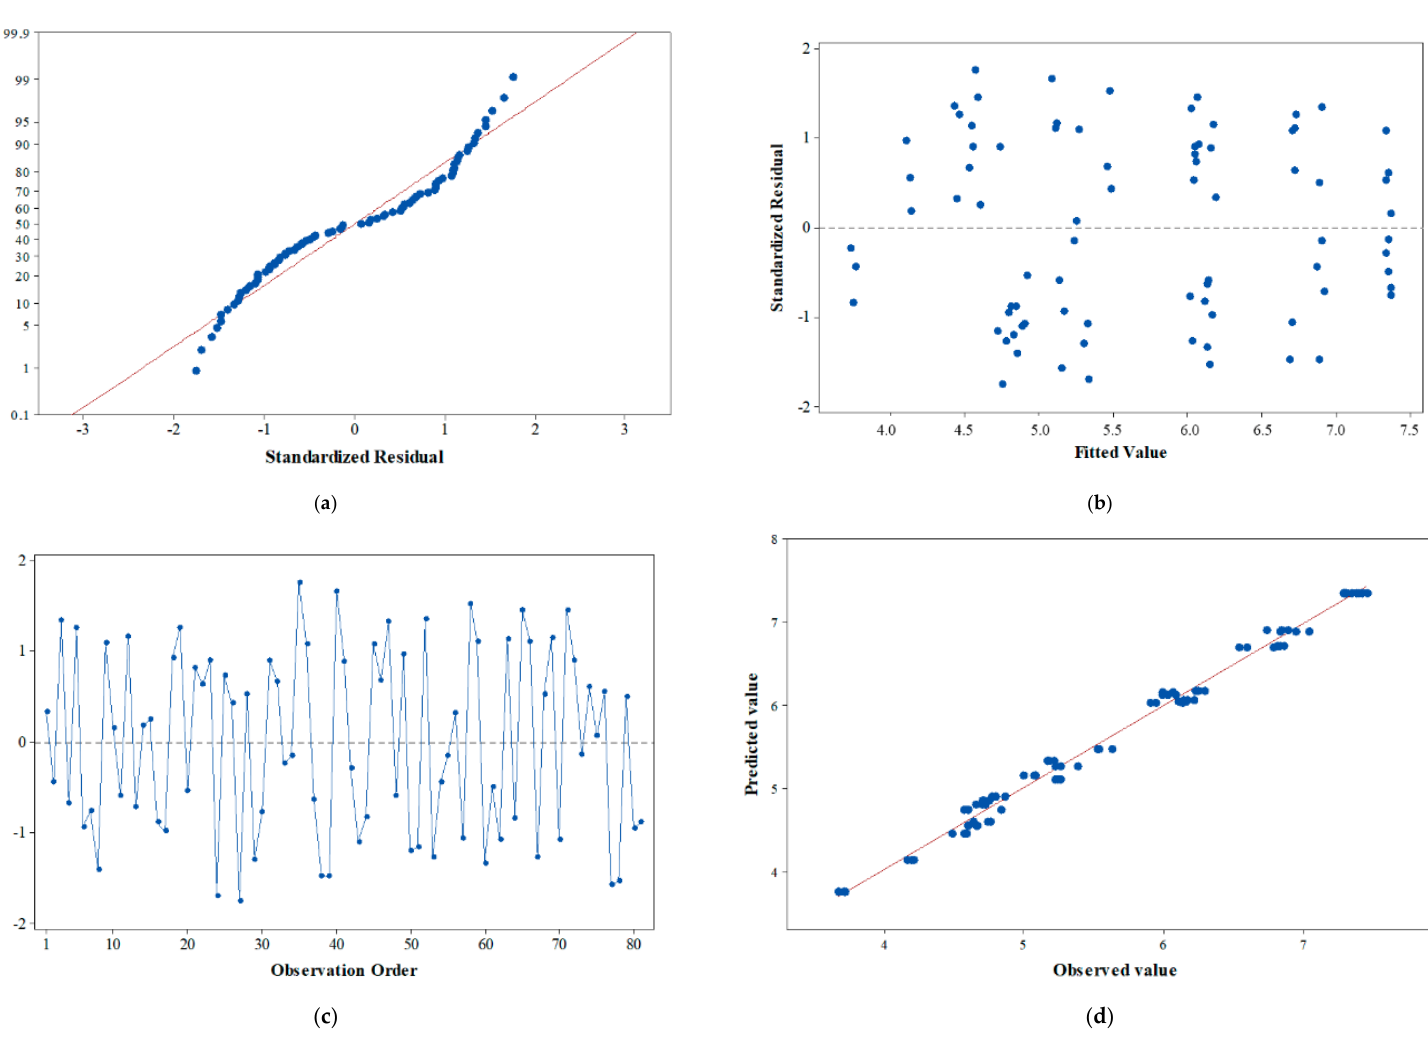
Figure 2. Model adequacy diagnostic plots: normal probability plot of residuals ( a ), plot of residuals against fitted values ( b ), plot of residuals against run order ( c ), and plot of predicted values against observed values ( d